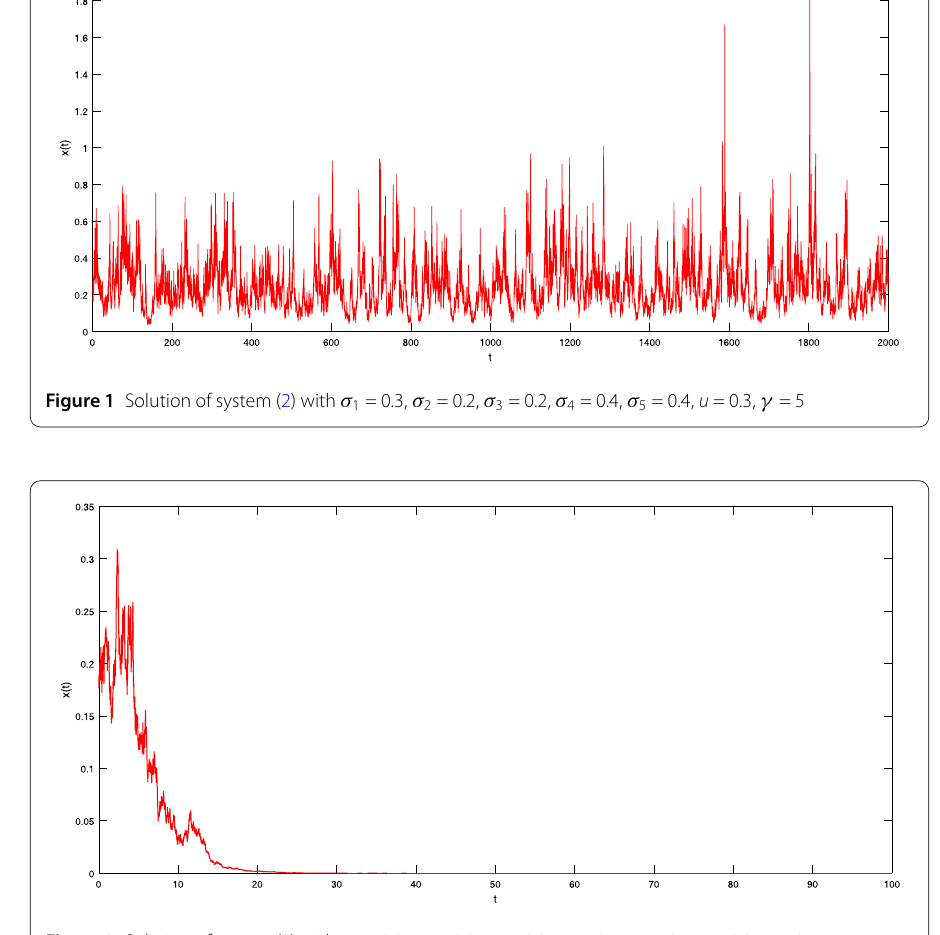
Figure 2 Solution of system (2) with σ 1 = 0.3, σ 2 = 0.2, σ 3 = 0.2, σ 4 = 0.4, σ 5 = 0.4, u = 0.3, γ =